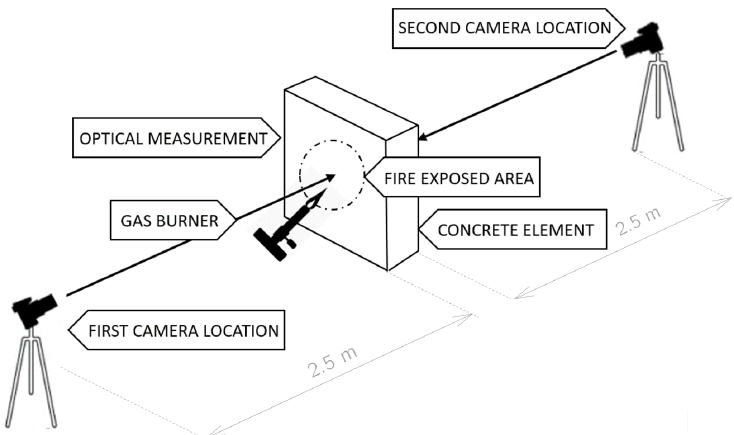
Figure 6. Scheme of the experimental stand.